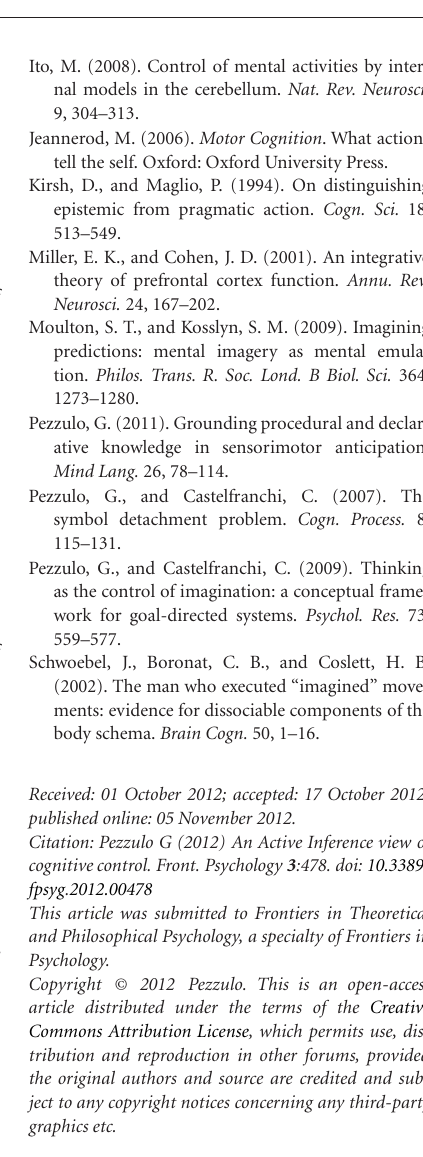
FIGURE 1 | Left: Active Inference framework. Right: “Controlled Predictions” and cognitive